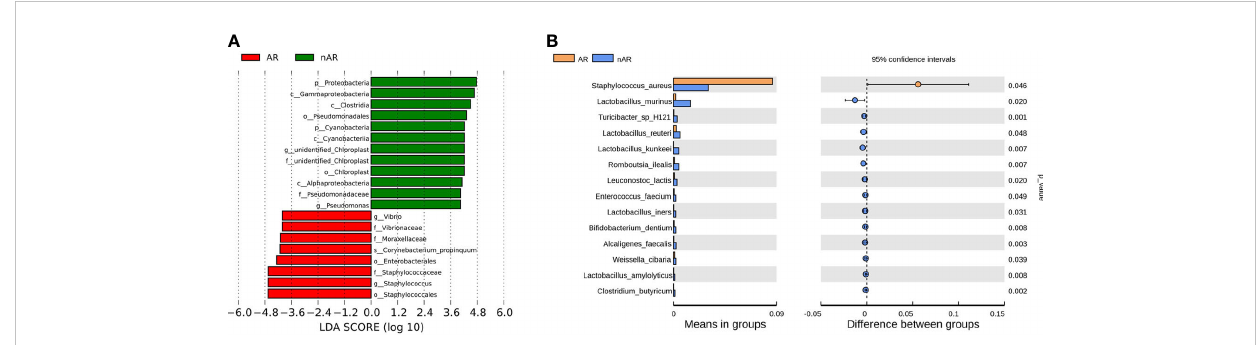
FIGURE 2 Species difference analysis was performed on the nasal fl ora of patients with allergic rhinitis and non-allergic rhinitis. lefSe analysis screened for different species with LDA>4 (A) , and t.test analysis screened for different species with p<0.05 (B) .